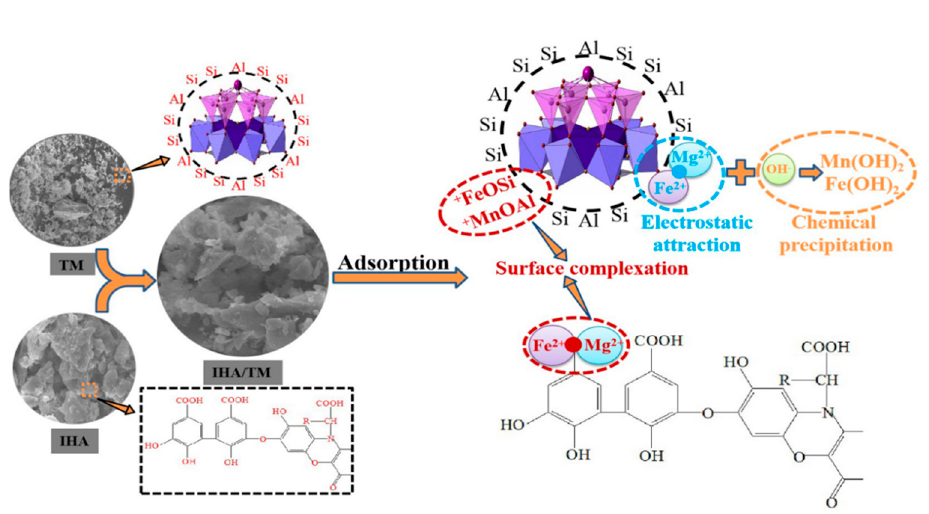
Figure 12. Schematic diagram of the adsorption mechanism of iron and manganese by IHA/TM composite